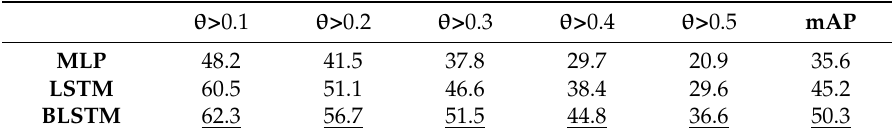
Table 3. Comparison of spatio-temporal action-detection performances (video-mAP) with the feature sharing on UCF-101 dataset.